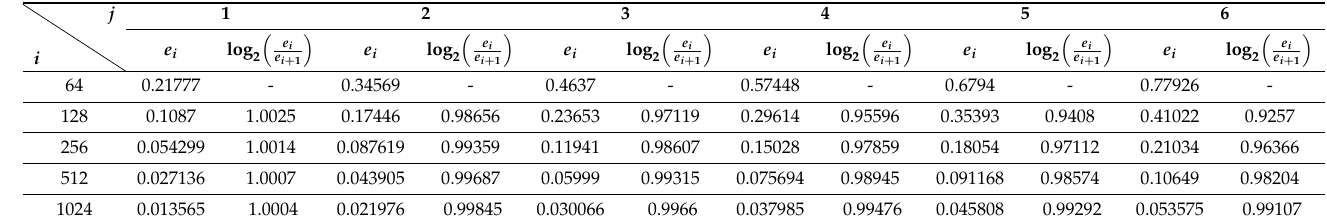
Table 2. Grid refinement analysis in the L ∞ norm for the numerical estimation of the order of approximation using j scales of subdivision. By i , we represent the number of initial control points that we use. We used the nonlinear scheme (with M equal to the harmonic mean in (3) and (4)) and the function in (24). For this piecewise continuous function, the greatest error is located at the discontinuity. Thus, the numerical errors presented in the table correspond to the errors at the discontinuity. We can see that they reduce as we refine the grid, reaching O ( h ) accuracy.